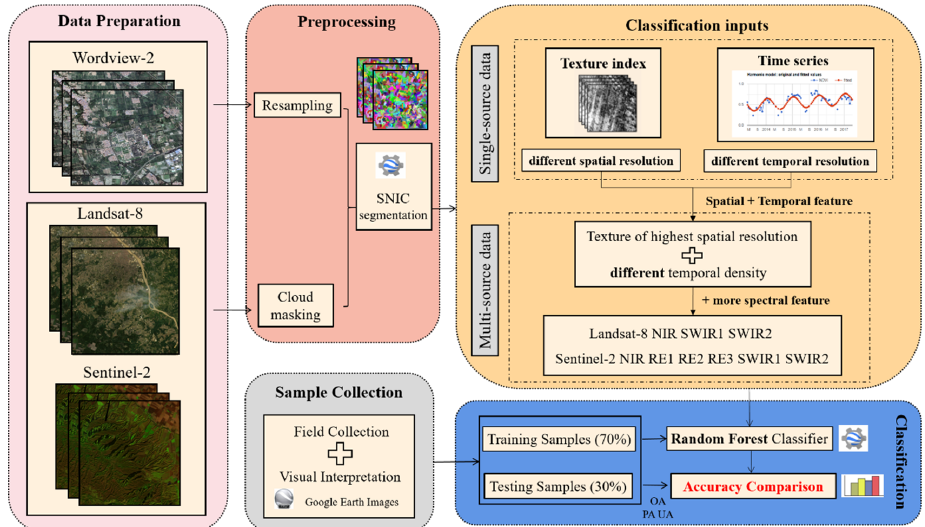
Figure 4. Workflow for orchard mapping of five grape-growing regions with different spatial and temporal resolutions.